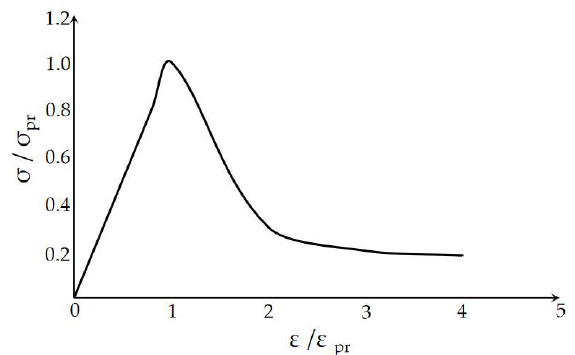
Figure 7. Stress–strain curve of uniaxial compression specimen. Figure 4 is described in mathematical